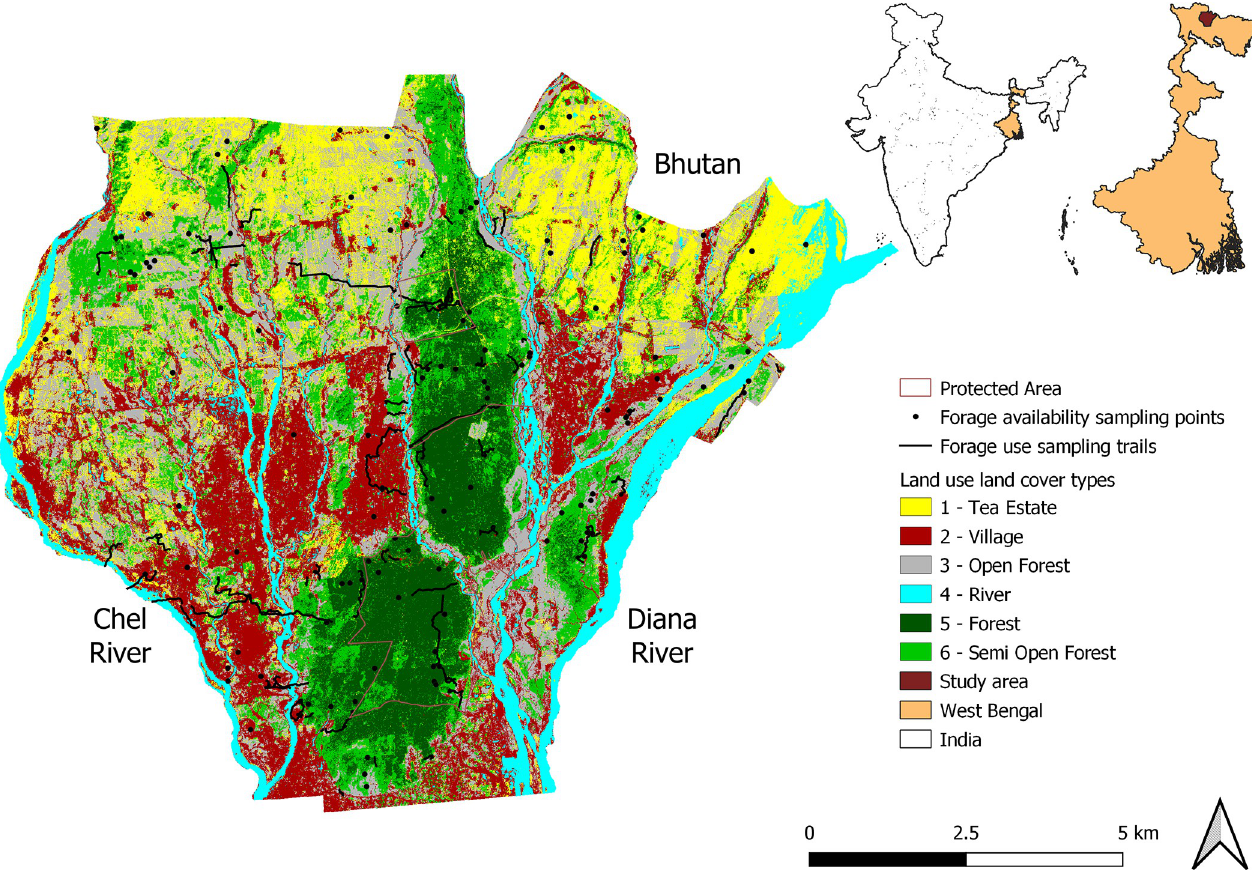
Fig 1. Land use land cover classification, forage use sampling trails, forage availability sampling points in the study area of West Bengal State.